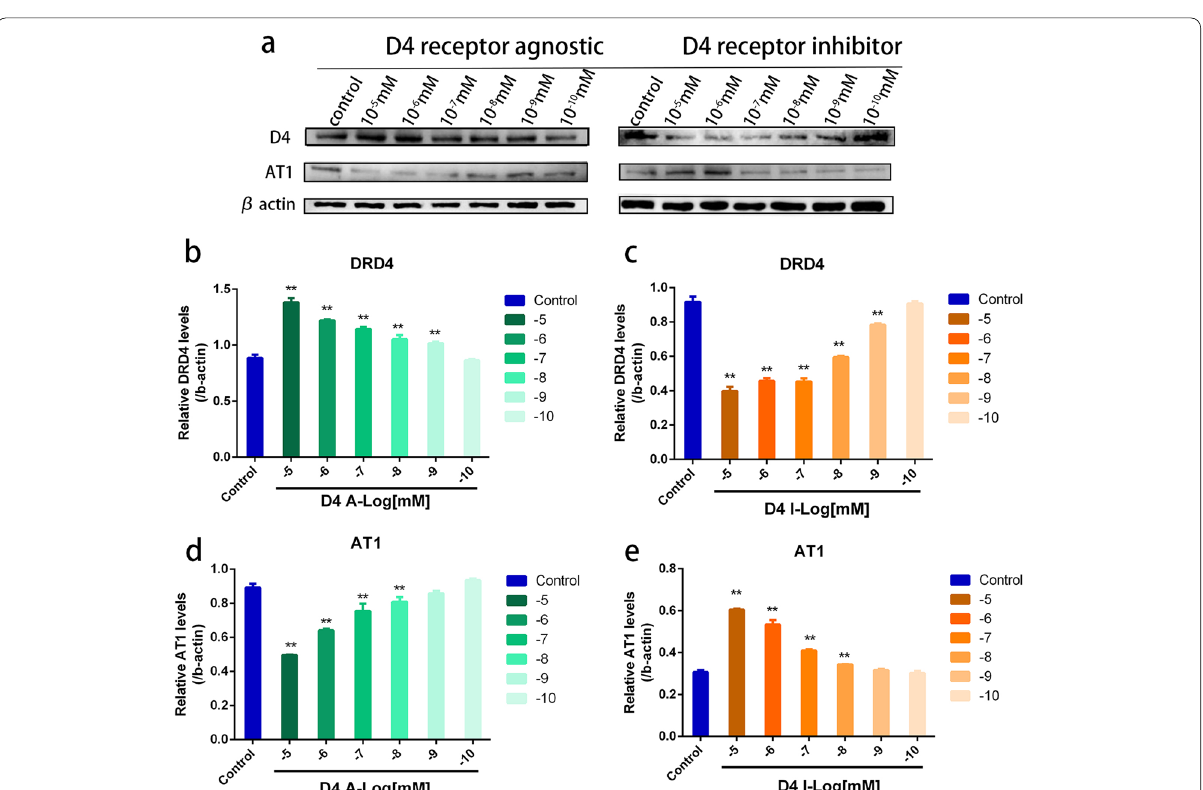
Fig. 7 Effect of dopamine receptor D4 (DRD4) on angiotensin II type 1 receptor (AT1) protein expression in primary vascular smooth muscle cells (VSMCs) of broilers. VMSCs were incubated with different doses of D4A or D4I for 24 h. a , b , c Dose-dependent effect of D4A (HY-101384A) or D4I (HY-B0965) ( n 6, ** P < 0.01 vs. control). a , d , e The dose-dependent effect of D4A or D4I ( n =